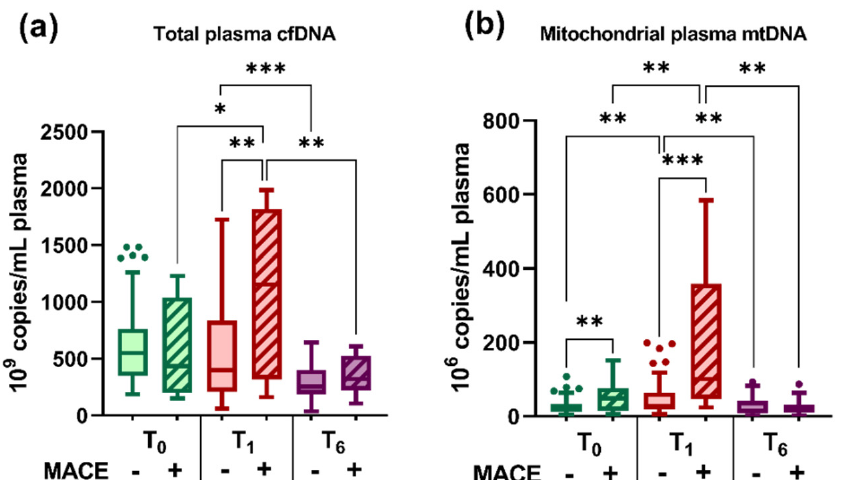
Figure 6. Variation of plasma levels of total cell-free (cfDNA) ( a ) and mitochondrial cfDNA (mtDNA) ( b ) in ST segment elevation myocardial infarction (STEMI) patients at T 0 , T 1 , and T 6 time points grouped by the occurrence of subsequent major adverse cardiovascular events (MACE) at 6-month follow-up. Data are illustrated as boxplots with Tukey whiskers and median line; the “-” symbol signifies the respective STEMI group without MACE, while the “+” symbol signifies the respective STEMI group with MACE. * p < 0.05, ** p < 0.01, *** p <